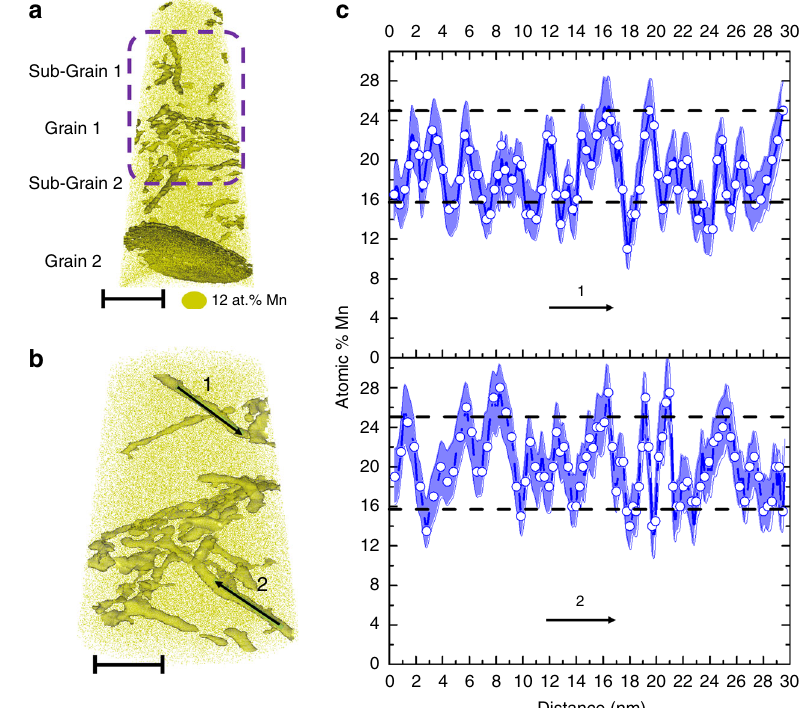
Fig. 1 APT analysis of dislocations decorated with Mn after 6 h at 450 °C. a The 12.5 at.% Mn iso-concentration surfaces (12.5 atomic % Mn was chosen as a threshold value to highlight Mn-enriched regions) showing two grain boundaries and numerous dislocations decorated by Mn. Scale bar, 40 nm. b Close- up on the middle section of the dataset indicated by the purple dashed line showing decorated dislocations. Scale bar, 30 nm. c 1D composition pro fi les along the two dislocations marked by the arrows in b ). The points are the experimental values, which are connected by blue lines for better visualization. The blue shading represents the statistical error associated with the calculation of the composition. The dashed lines show the typical values of compositional fl